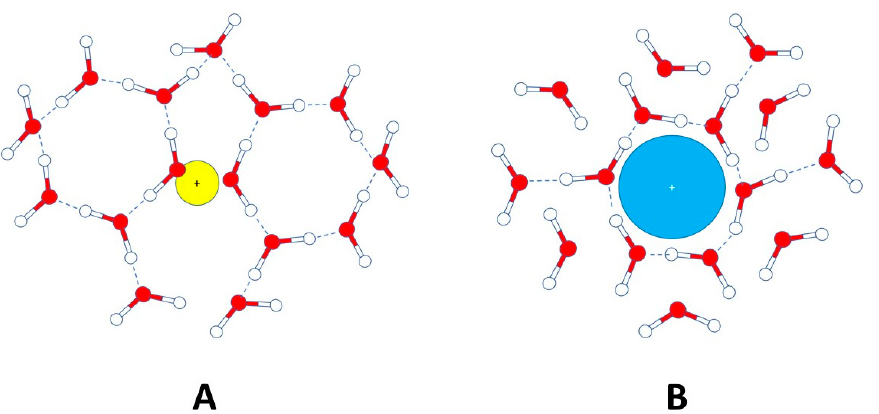
Figure 16. ( A ). Low-density ice-like layer around a kosmotropic ion. ( B ). High-density water around a Figure 16. A . Low-density ice-like layer around a kosmotropic ion. B . High-density water around a chaotropic chaotropic ion.